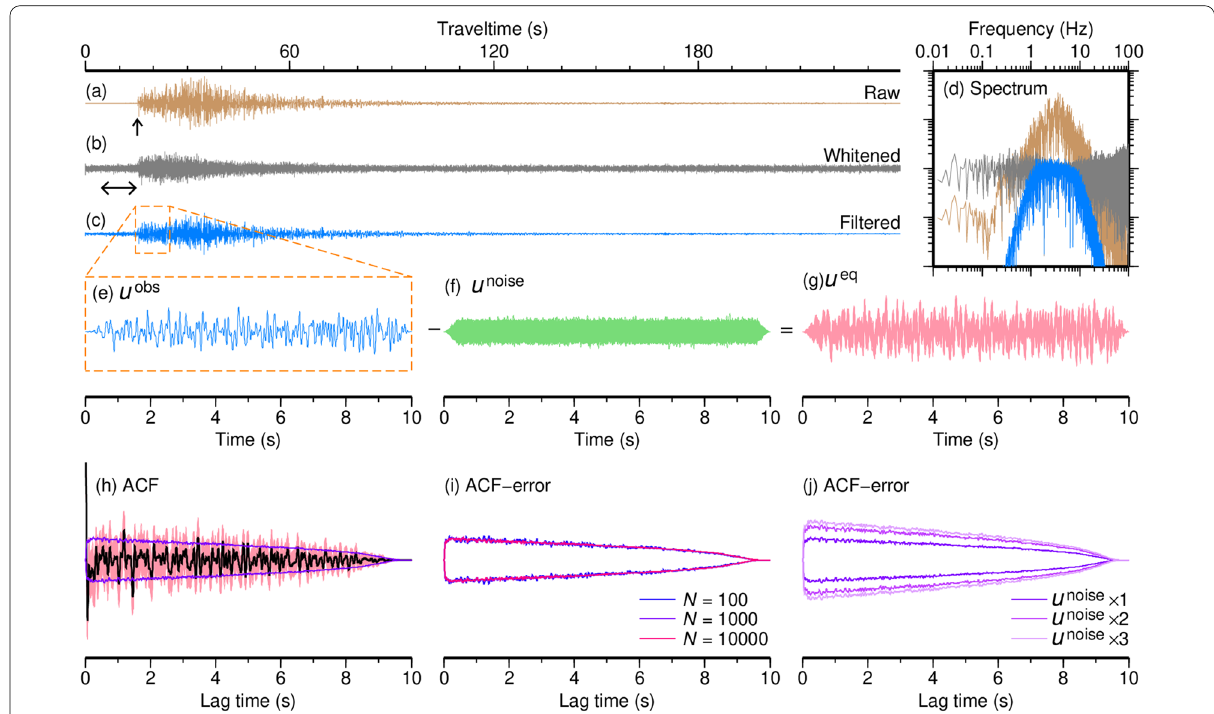
Fig. 2 Estimation of ACFs and errors using the largest earthquake at E.STHM as an example. a Raw waveform. The lateral axis is taken from the earthquake origin time. The arrow indicates the manually identified P-wave arrival time T p i . b Whitened waveform. The arrow indicates the noise window, which is defined as 10.5–0.5 s before T p i . c Bandpass-filtered (1–10 Hz) waveform. The orange square indicates the P-wave window, which is defined as between 0.5 s before and 9.5 s after T p i . d Fourier amplitude spectra of the raw (brown), whitened (gray), and bandpass-filtered (blue) waveforms. e Filtered waveform in the P-wave window multiplied with a 0.5 s cosine taper to both sides ( u obs i ( t ) ). f Filtered noise traces ( u noise i , j ( t ) ) generated by applying the same bandpass filter and taper that is used to generate u obs i ( t ) to 1000 candidates of random traces. g 1000 candidates of u eq i , j ( t ) (Eq. 2). h 1000 candidates of a eq i , j (τ) (Eq. 3; pink), their ensemble average ( a ave i (τ) ; black), and three times their standard deviation ( 3 σ a i (τ) ; purple). i 3 σ a i (τ) for 100, 1000, and 10,000 random traces. j Effects of the noise level on the estimates of 3 σ a i (τ) . The results from two and three times the actual noise level are shown. Common amplitude scales are used for e – g and h –